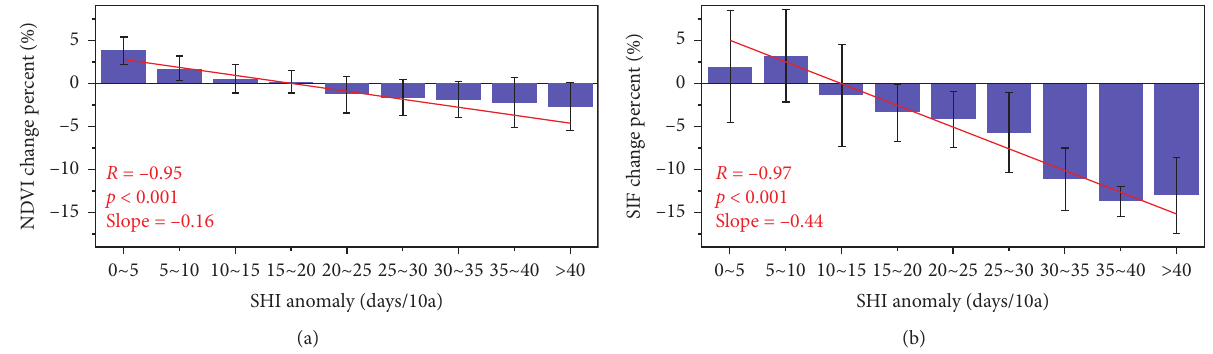
Figure 6: The comparison between (a) NDVI change percent and (b) SIF change percent and the number of heat wave days anomaly per decade (SHI anomaly) as compared with multiyear values during 2008–2014. The NDVI and SIF change percentages were calculated by averaging SHI anomaly bins with intervals of 5 days.